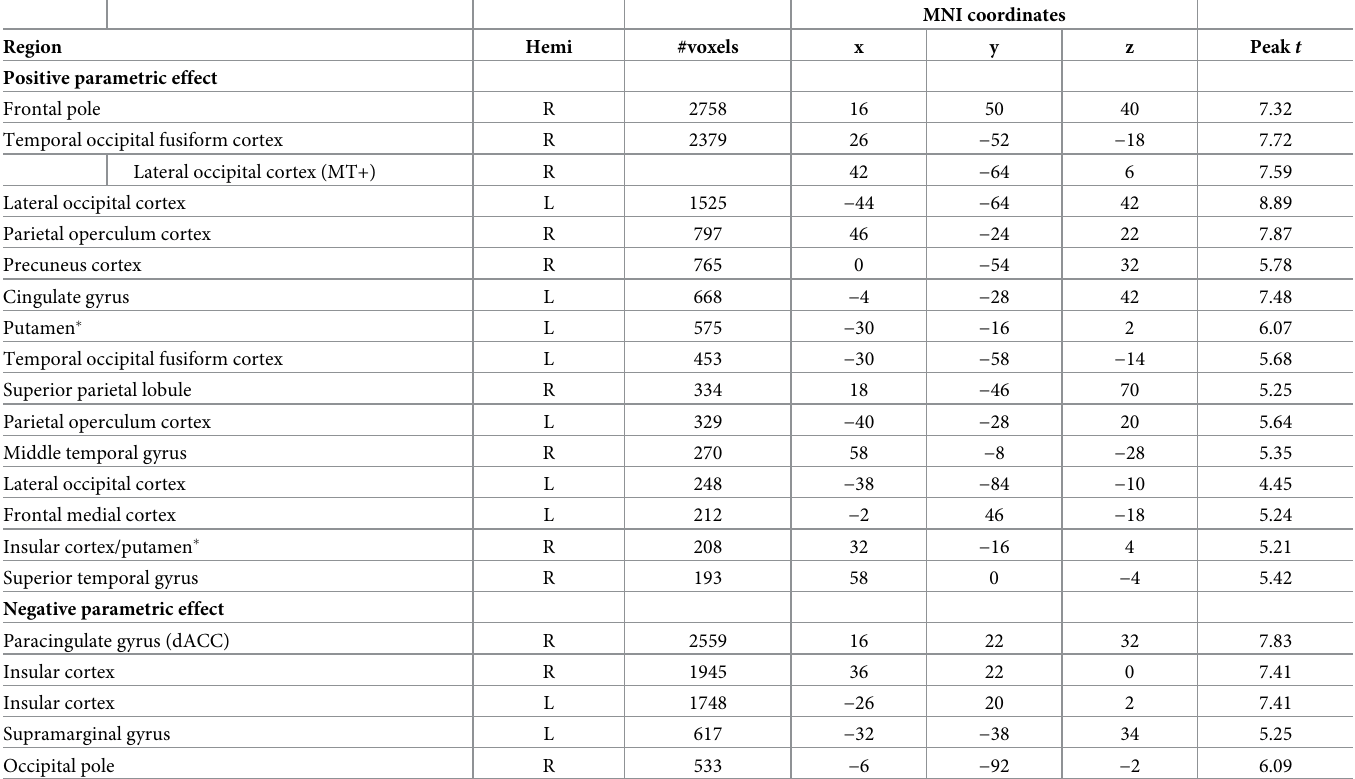
Table 1. Regions showing significant activation by parametric effect of motion coherence during performance of direction discrimination task (cluster-level FWE- corrected P <